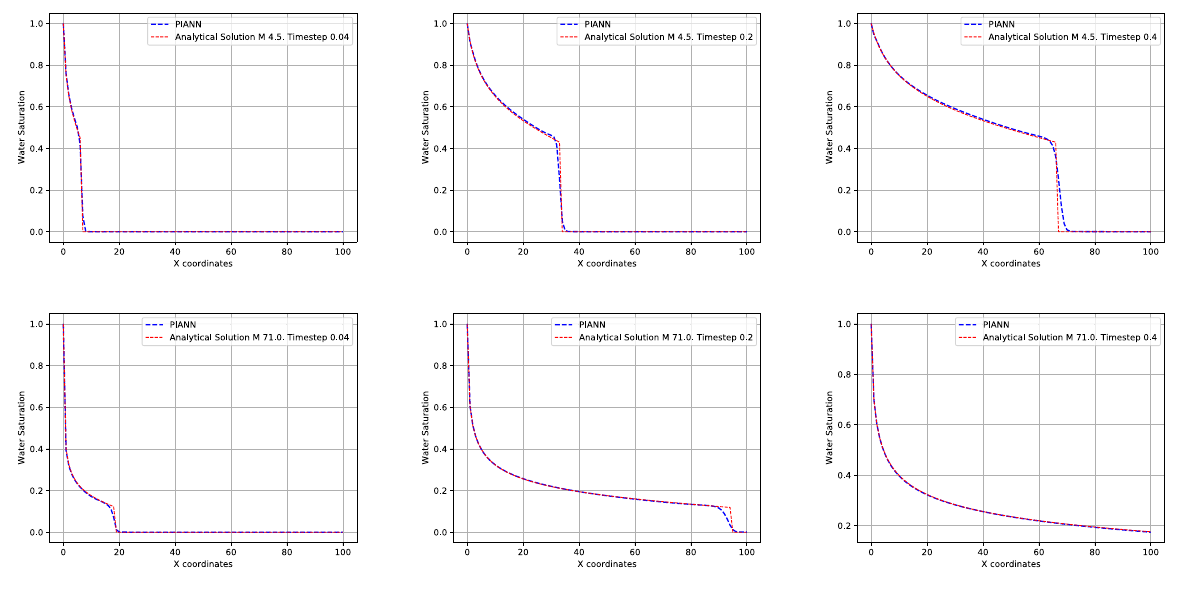
Figure 4. Top and bottom rows correspond to M = 4.5 and M = 71 for comparison of the predicted by the neural network and the exact solutions of the PDE, respectively. The columns from left to right, correspond to different time steps t = 0.04 , t = 0.20 and t = 0.40 .